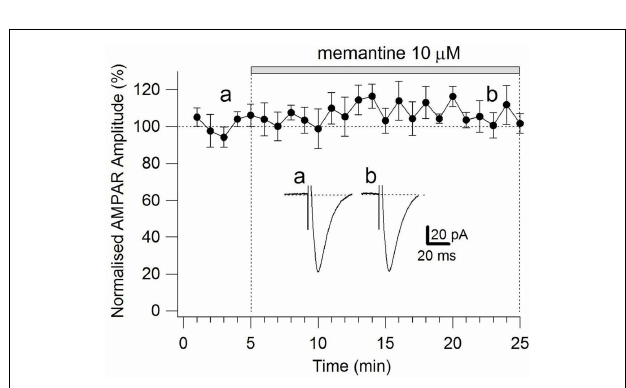
FIGUREA4 |Time-course of the effects of memantine onAMPAR currents in PCs. AMPAR currents were recorded from individual PCs voltage-clamped at V m =− 70mV. Normalized AMPAR current amplitudes (%) are plotted as a function of time. Each point (one every min) is the average of six points (stimulations every 10s).The bars indicate the duration of memantine exposure. Examples of traces of AMPAR currents measured before (a) and after memantine (b) application are shown for a PC. Each trace is an average of 30